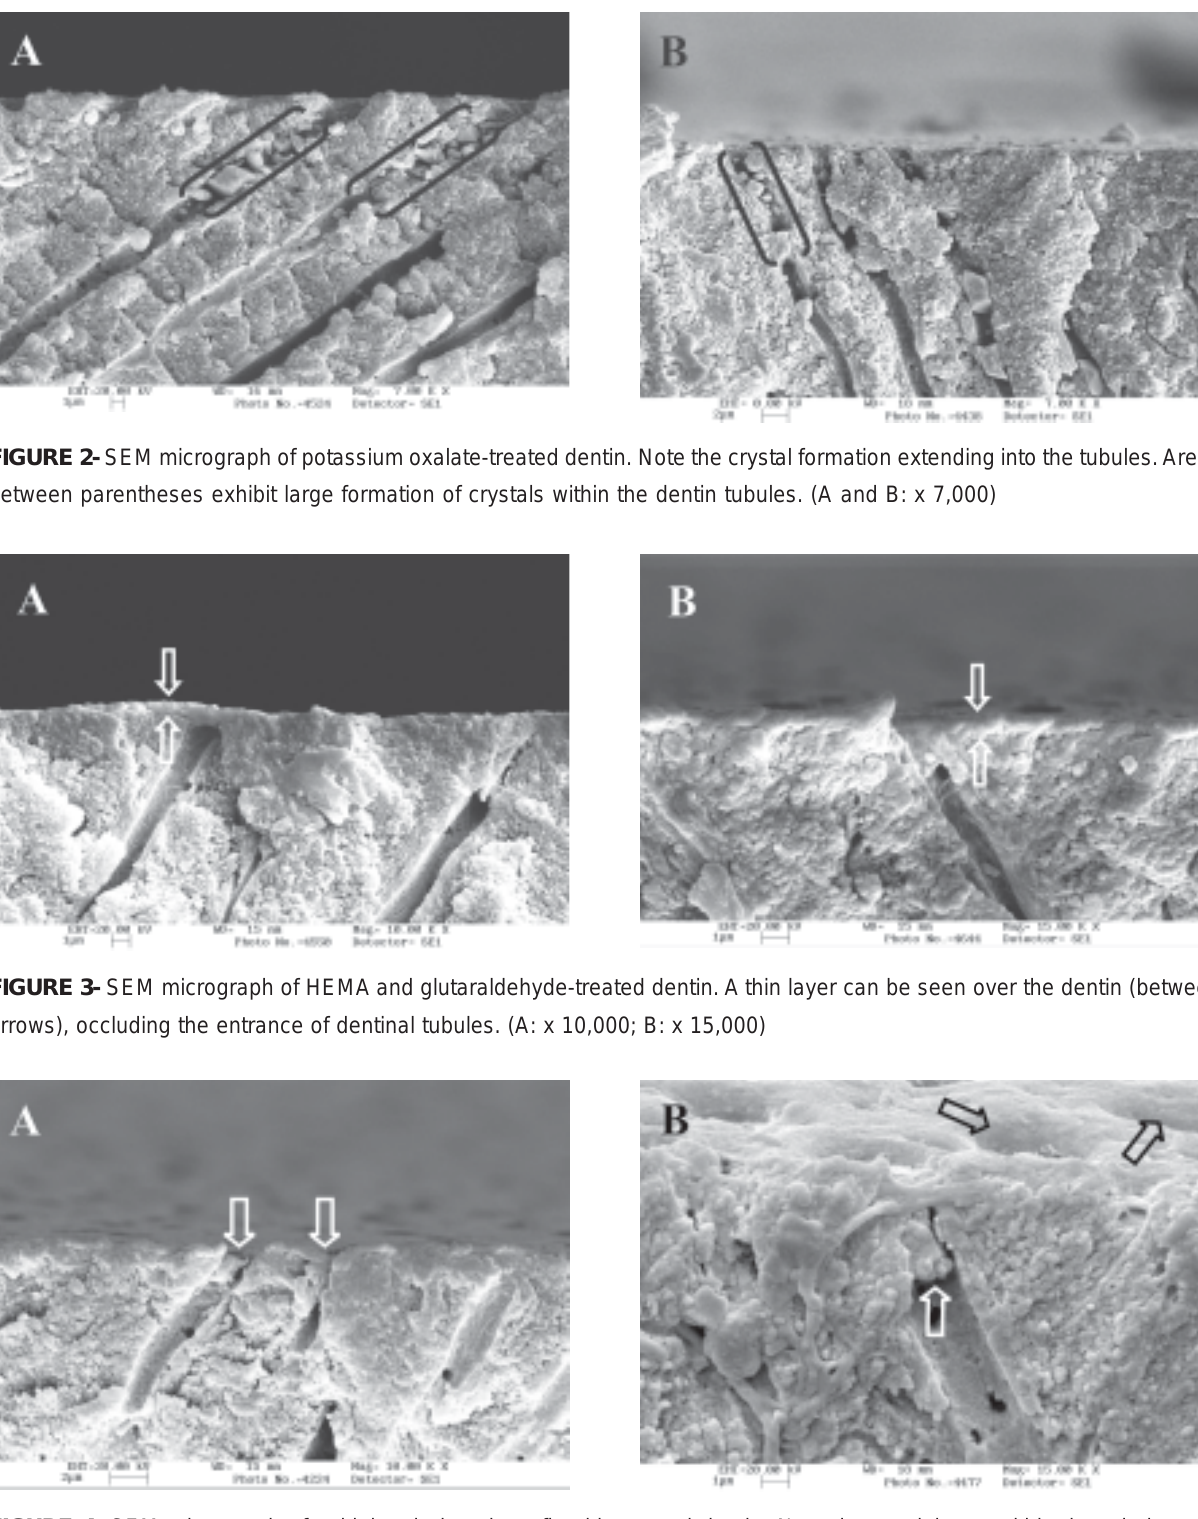
FIGURE 4- SEM micrograph of acidulated phosphate fluoride-treated dentin. Note the precipitates within the tubules and below the surface (white arrow), and the funnel shape dentinal tubules opening (black arrows). (A: x 10,000; B: x